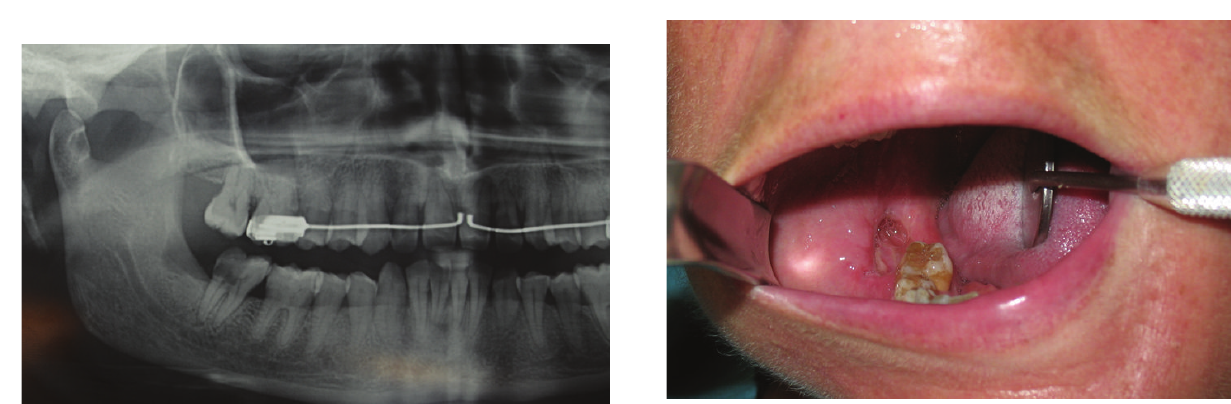
Figure 1: Clinical view of the area of necrosis and inflammation in maxillary second and third molars.